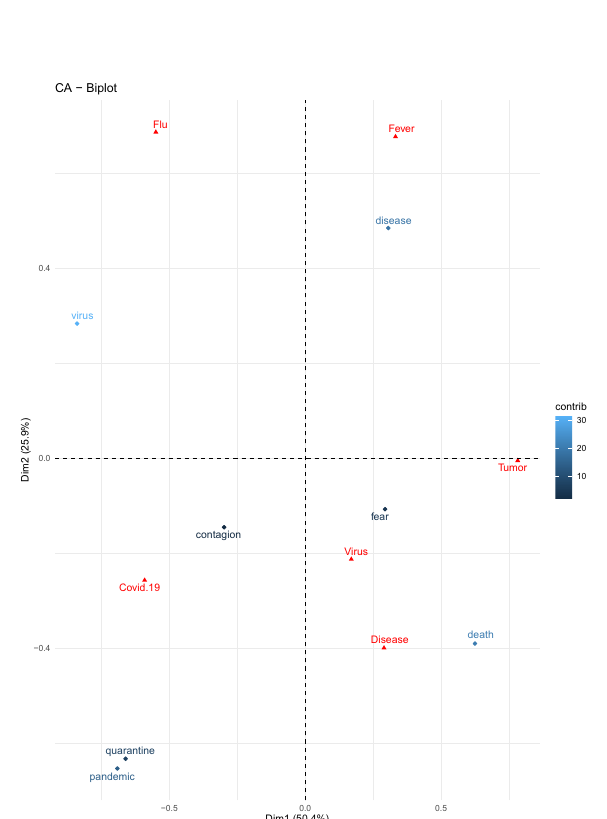
Figure 4. Plot of dimensions 1 and 2 of words that were most frequently produced for COVID-19, and their relation with the target